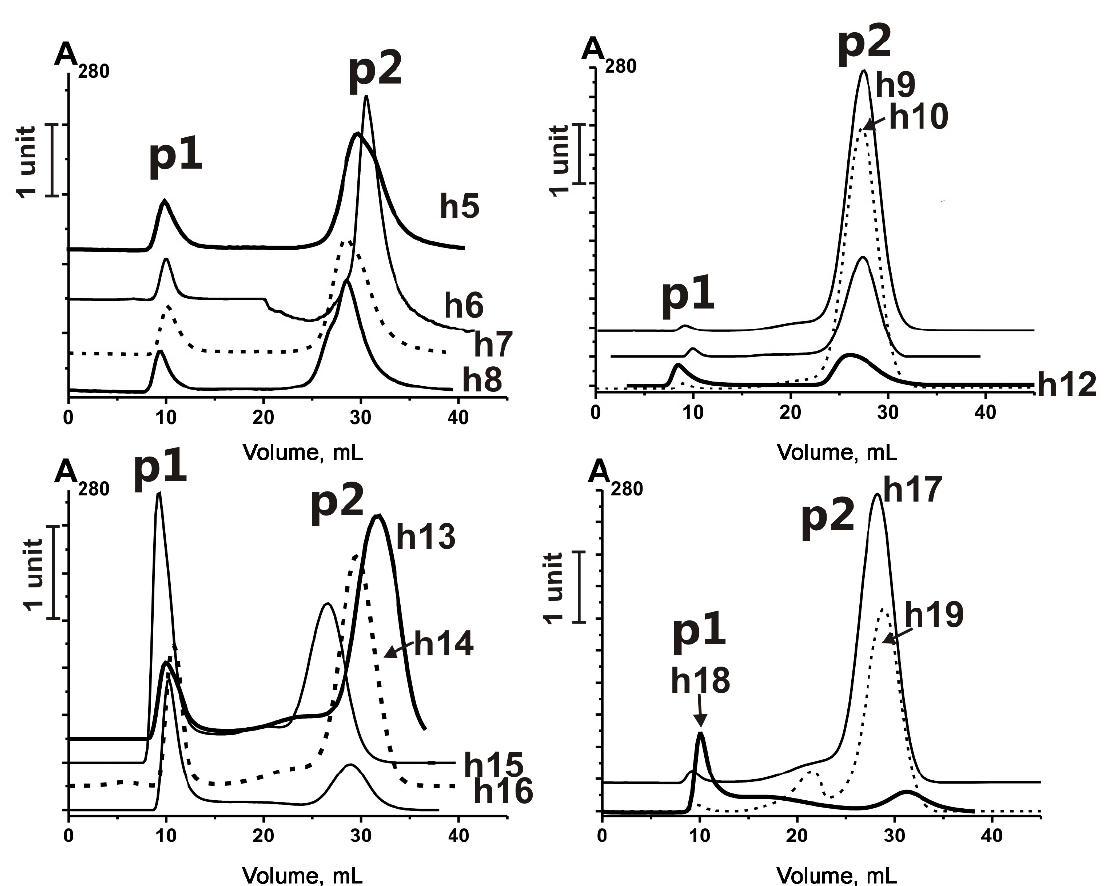
Figure 1. Profiles of Ultrogel A4 gel filtration of horse milk exosome-enriched fractions obtained using ultracentrifugation. p1—the first peak of elution, containing exosomes, p2—the second elution peak, containing co-precipitated impurities. h5–h19—horse milk samples, used for the exosome isolation (for data on h1–h4, see [35]).